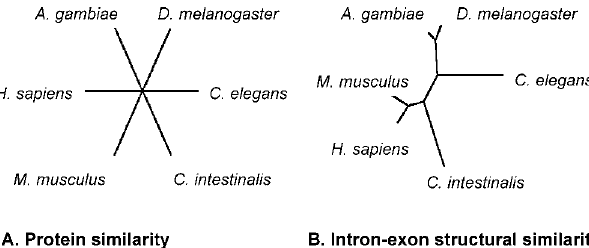
Figure 5. Controlling for the Impact of Unequal Rates of Protein Evolution on the Evolution of Intron–Exon Structures (A) Unrooted neighbor-joining tree based upon amino acid similarities for reciprocal best-hit best HSPs having 1.25 bits/aligned amino acid pair. (B) Unrooted neighbor-joining tree based upon similarities in the intron– exon structures of those same HSPs. DOI: